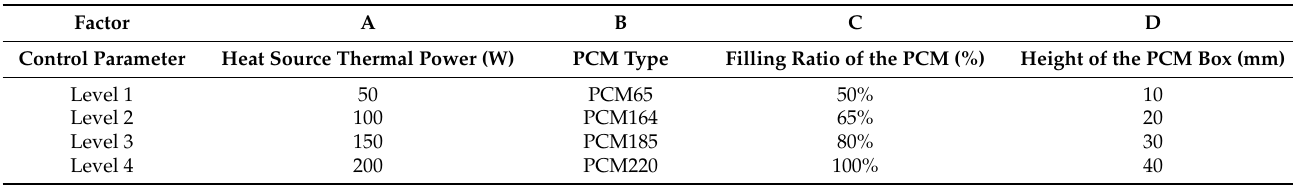
Table 1. Factors, control parameters, and the levels.